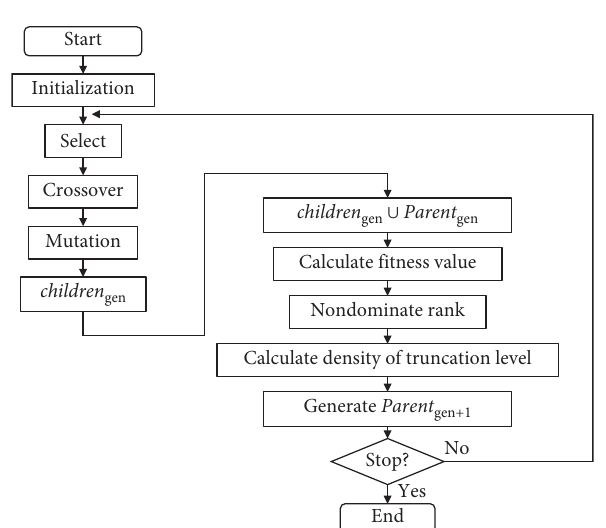
Figure 7: Flow chart of the algorithm.